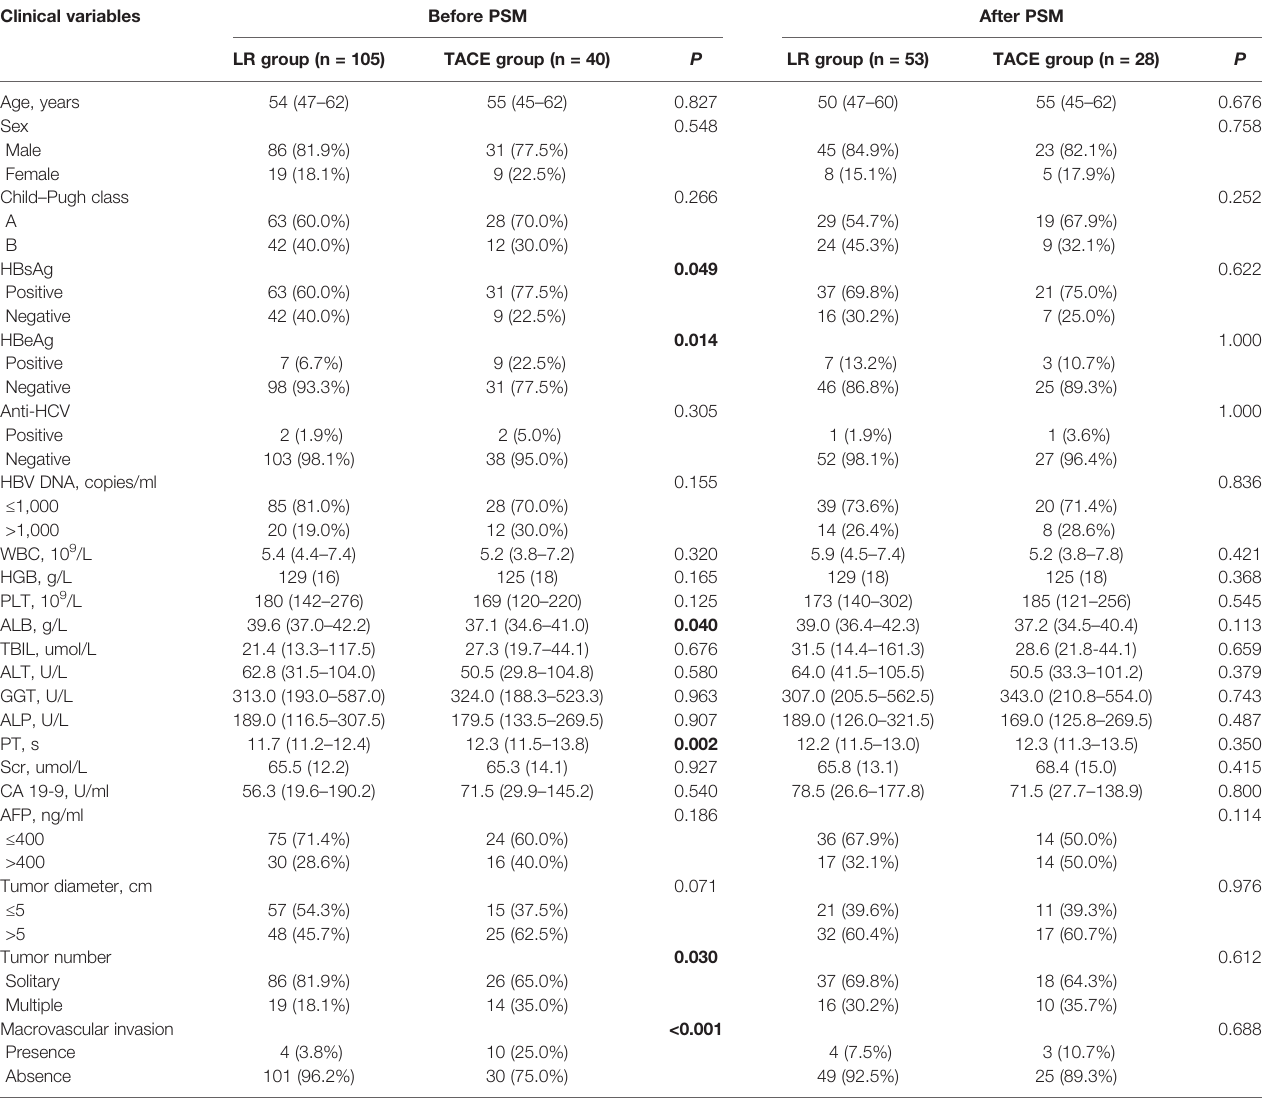
TABLE 1 | Baseline characteristics of HCC patients with BDTT before and after